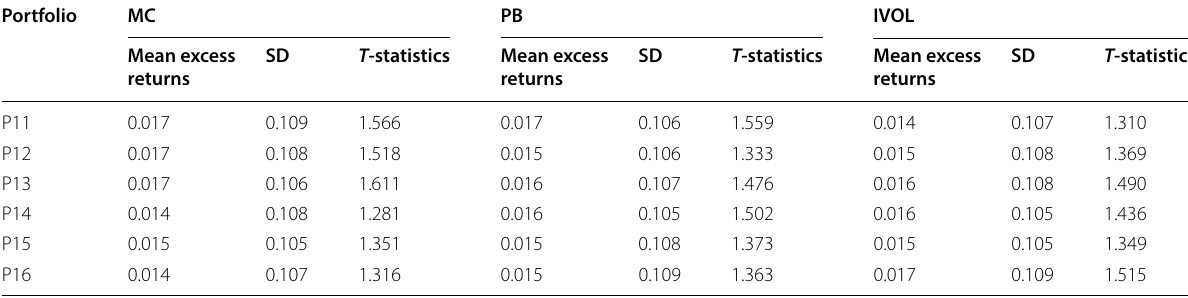
Table 4 Summary statistics of six portfolios formed on MC, PB and IVOL Portfolio